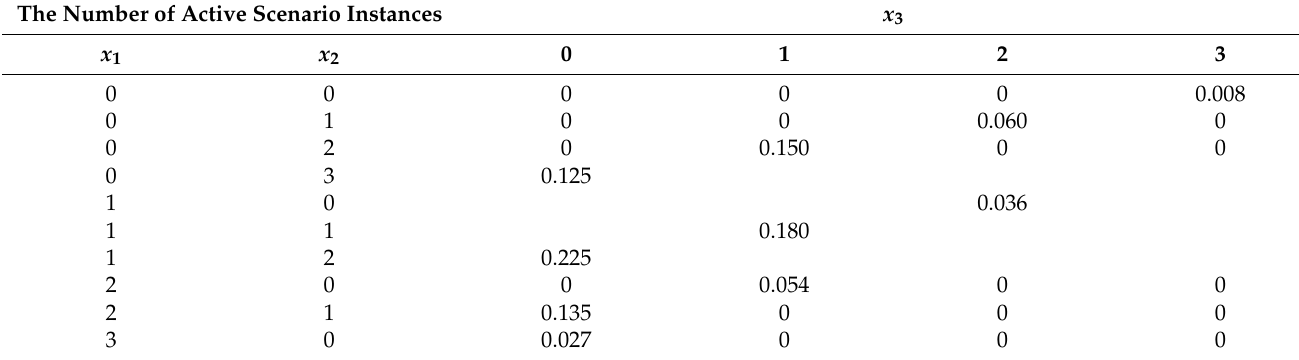
Table 4. The combination probabilities of the scenarios in the railcar under the assumption that there are precisely three scenario instances running at the same time ( x n = 3 )